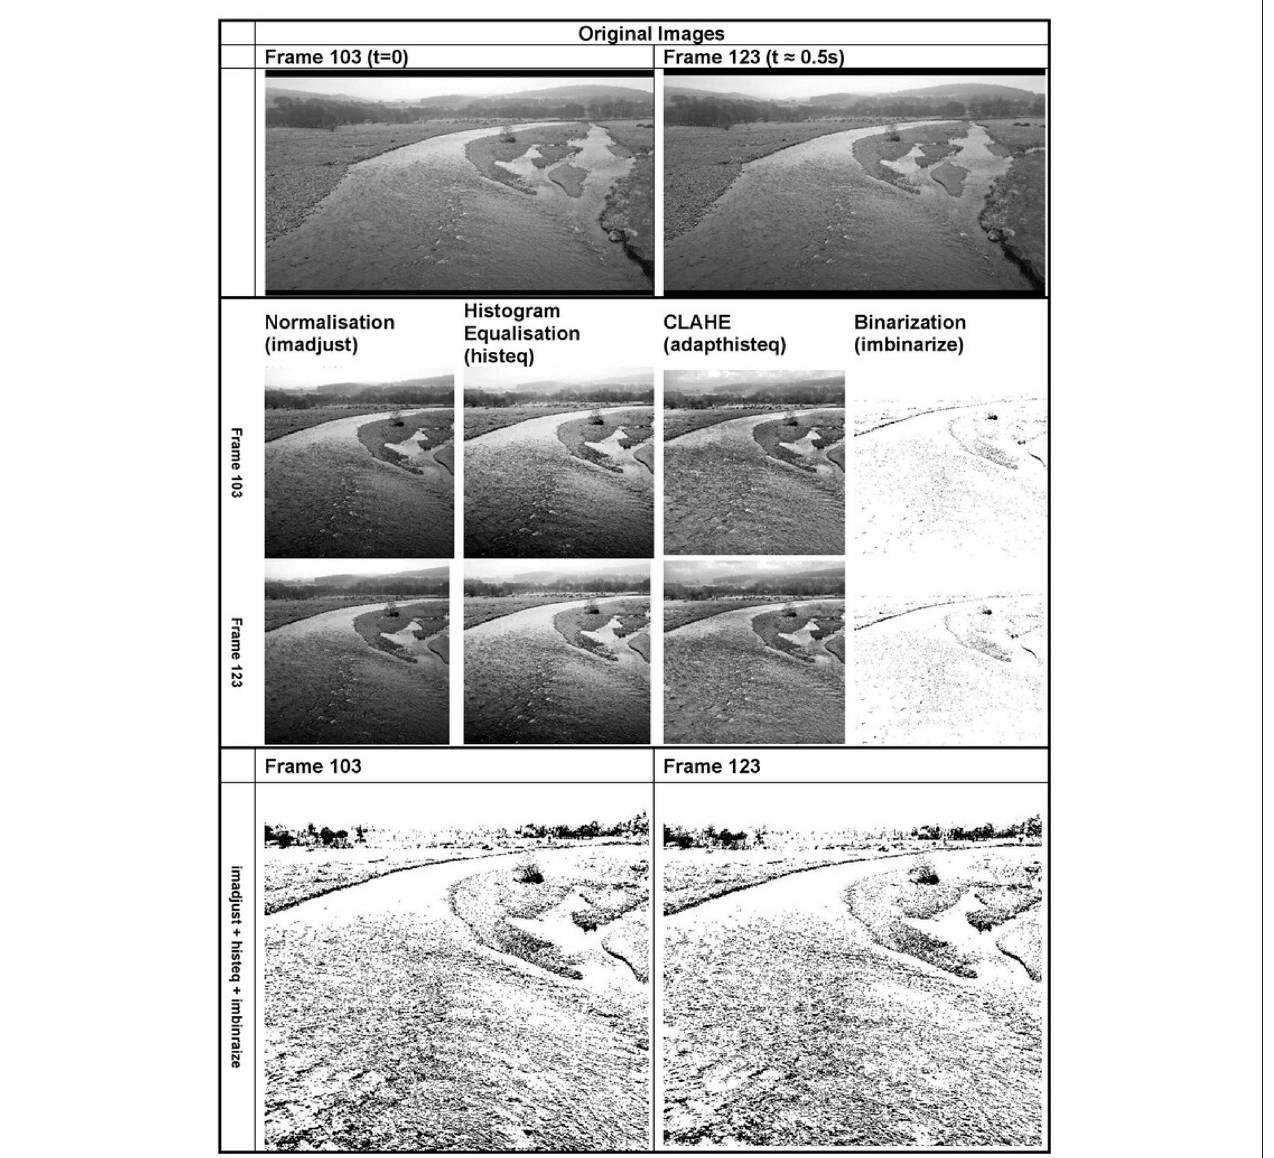
FIGURE 10 | A series of image manipulation processes performed in Matlab using frames from the same video file. Note the amount of information in the binarized images if normalisation and histogram equalisation is performed prior. This shows that there are cases where more than one method of pre processing can improve the amount of data that is traceable by